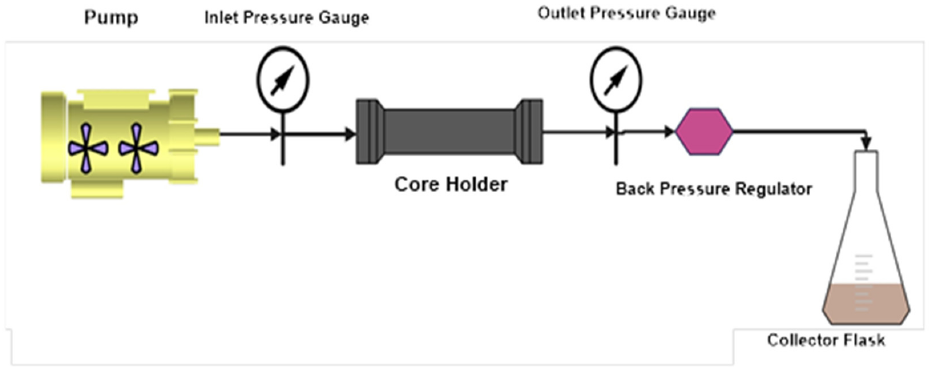
Figure 2. Core Flooding Schematic.